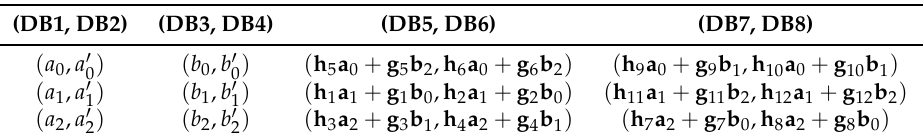
Table 14. Answers for W 2